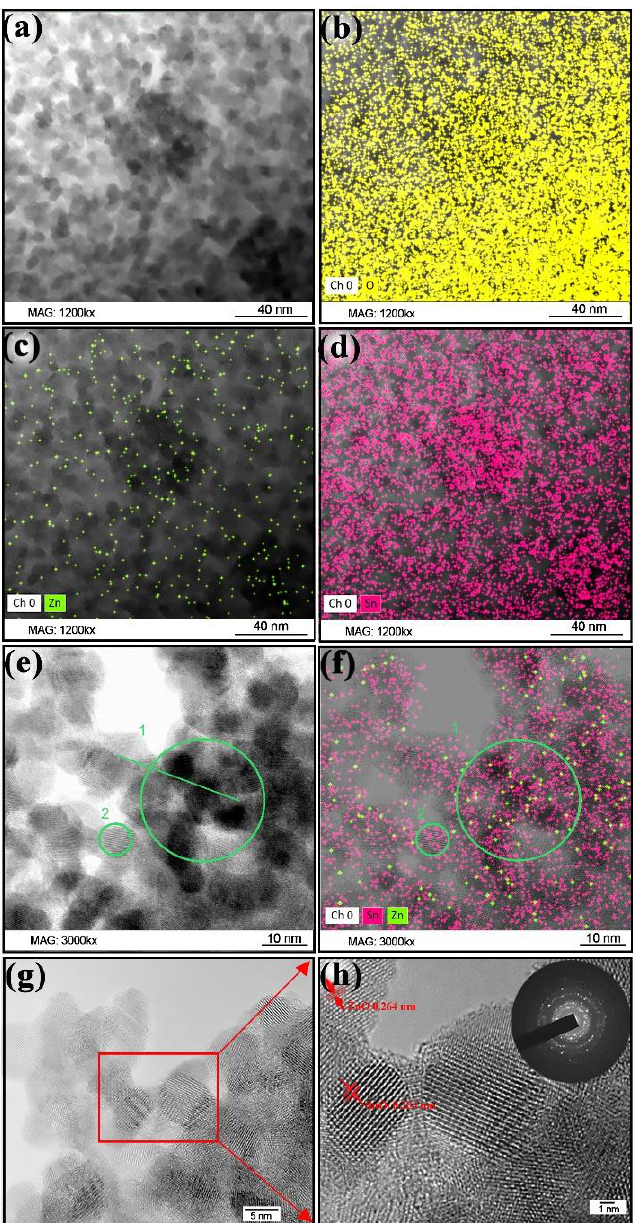
Figure 4. TEM characterization results of ZnO-SnO 2 materials: ( a , e , g ) TEM images with different magnifications; ( b – d , f ) EDS elemental mapping images; ( h ) HRTEM image and insert to the right at the top — SAED images.